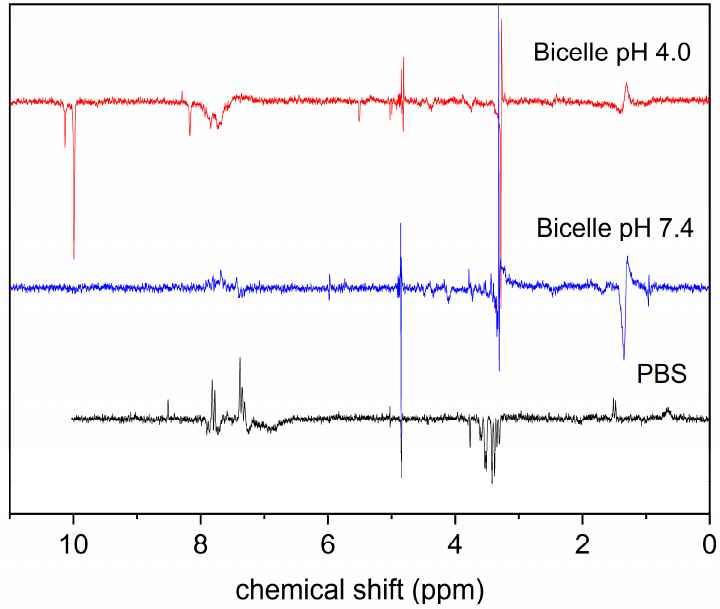
Figure 9. CIDNP spectra detected during photolysis of a mixture of KP (2 mM) + tryptophan (4 mM) in phosphate buffer and DMPC/DHPC bicelles at various pH (aerated solution). CIDNP signs of Trp protons (A on aromatic protons, 7.4 and 7.8 ppm and E no CH 2 group, 3.4 ppm) correspond to triplet radical pair ( а (indol) < 0, a(CH 2 ) > 0, Δ g < 0). In PBS, polarized products of the monomolecular decay of KP (HCOOH, 8.5 ppm), as well as po- larization of the CH 3 group of KP (1.5 ppm) were still observed. In bicelles, there is no CIDNP on aliphatic protons of KP, which, together with the absence of the corresponding products of monomolecular decomposition, indicates that the channel of the